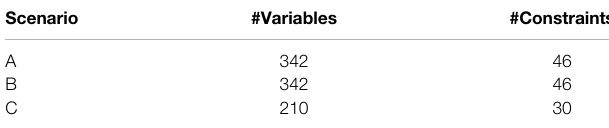
TABLE 2 | Variables and constraints for the MILP problem formulations.